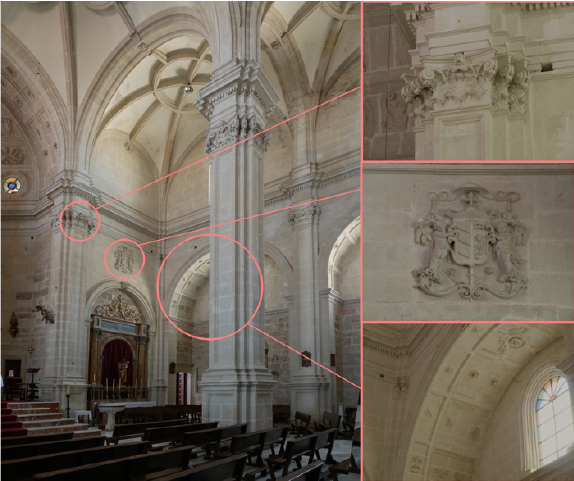
Figure 2. Interior of the church of Nuestra Señora de los Remedios,